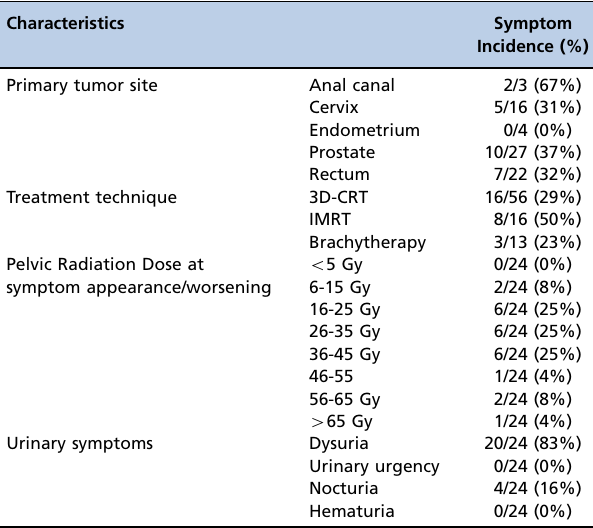
Table 2 - Characteristics of the 24 (33%) symptomatic patients and their respective symptom incidences during radiation